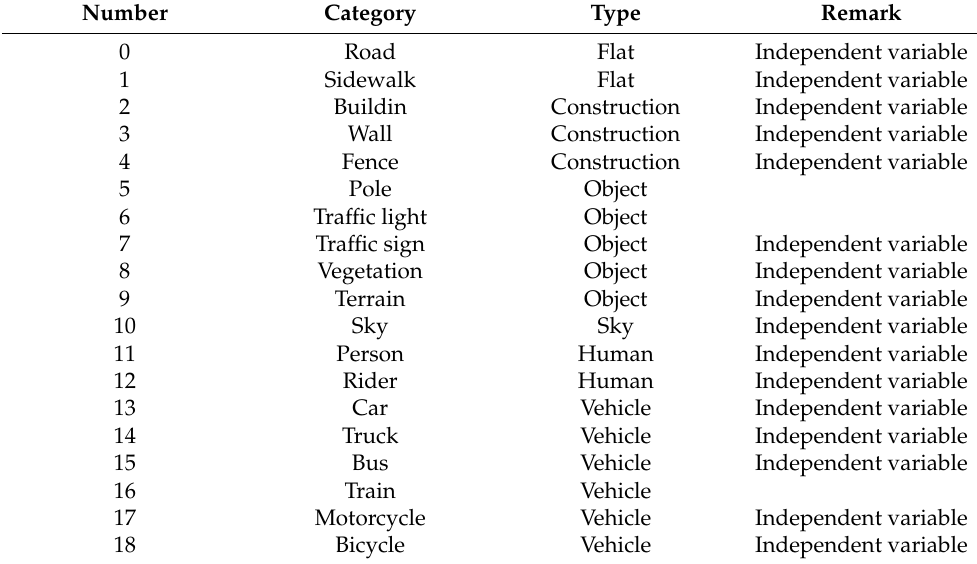
Table 1. Segmentation items in the recognition of images in Google Cityscapes’ ratings dataset.